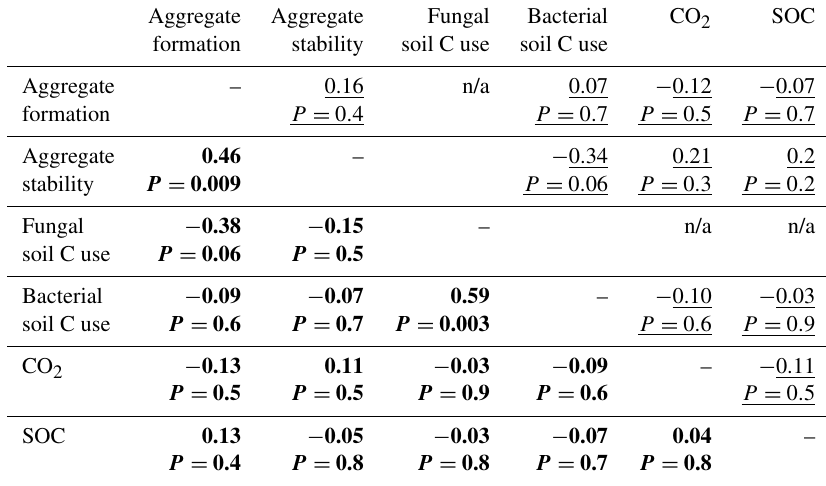
Table A2. Correlation matrix among variables describing soil aggregation and overall C use. Spearman’s correlation coefficients ( ρ ) for the bacterial-based system (underlined) and the fungal-based system (in bold). The term n/a indicates not